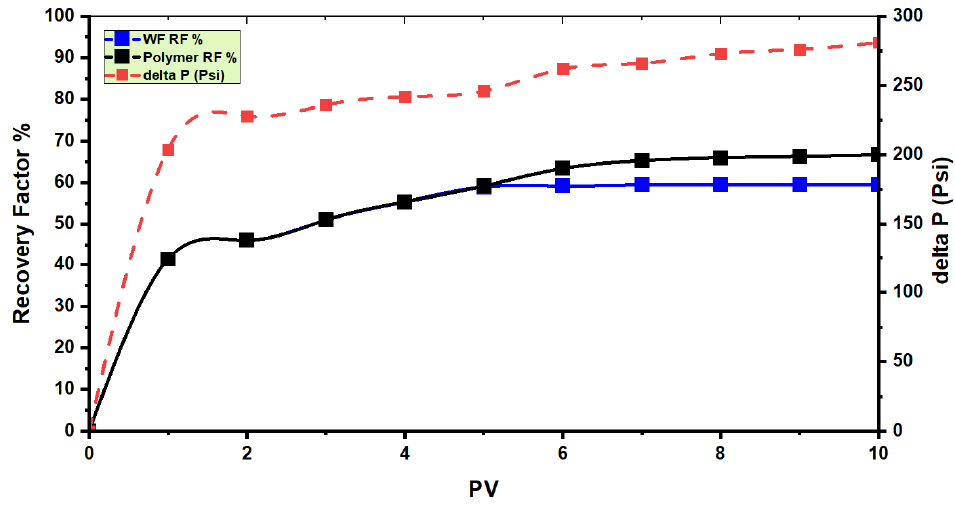
Figure 7. Recovery of oil by natural polymer flooding (okra) at reservoir temperature.